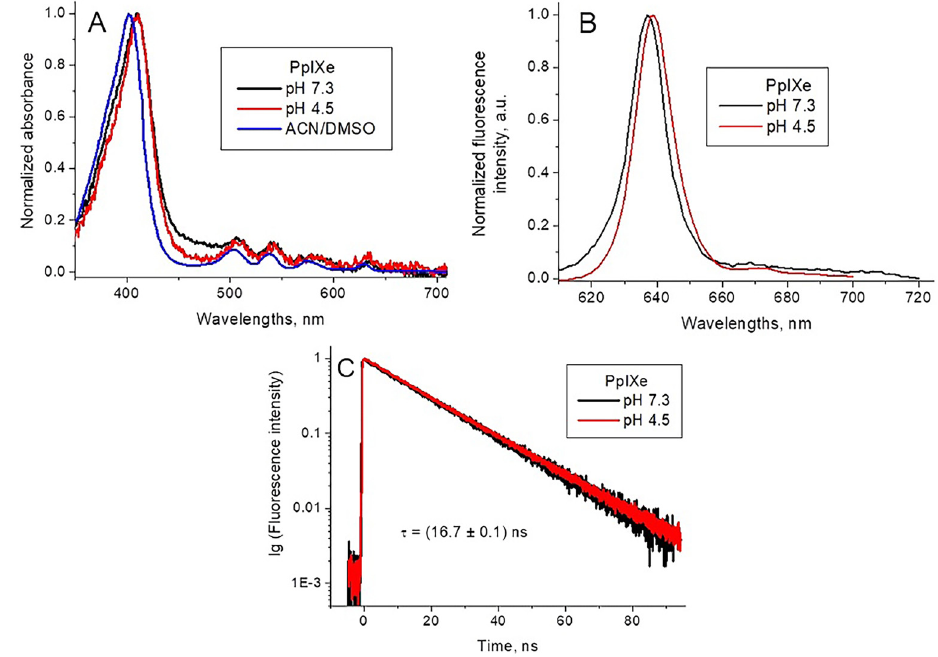
Figure 3. Normalized optical absorption ( A ) and fl uorescence ( l ex=420 nm) ( B ) spectra of endogenous protoporphyrin (PpIXe) in different solutions. PpIXe fl uorescence decay kinetic curves and respective fi ttings at pH 7.3 and pH 4.5 ( C ) ( l ex=420 nm, l em=637